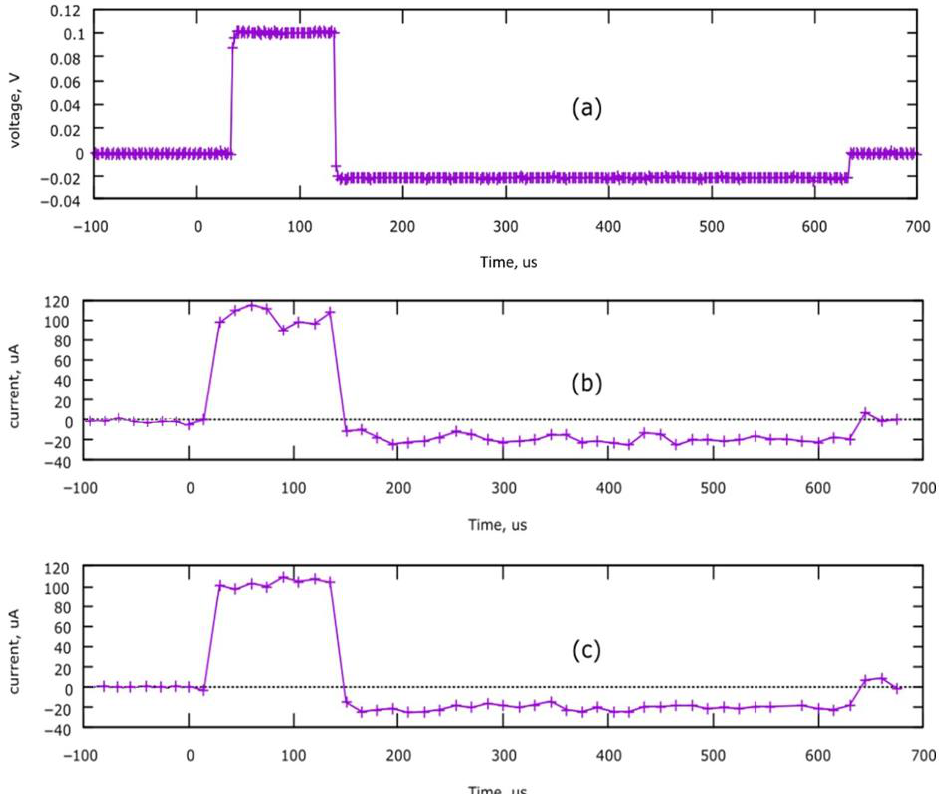
Figure 8. Brain stimulation pulse recordings. Pulse settings: Apulse = 100 µA, Tpulse = 100 µs. ( a ) Oscilloscope recording on 1000-ohm resistor; ( b ) Internal microcontroller’s ADC recording on 1000-ohm resistor; ( c ) In vivo internal microcontroller ADC recording.